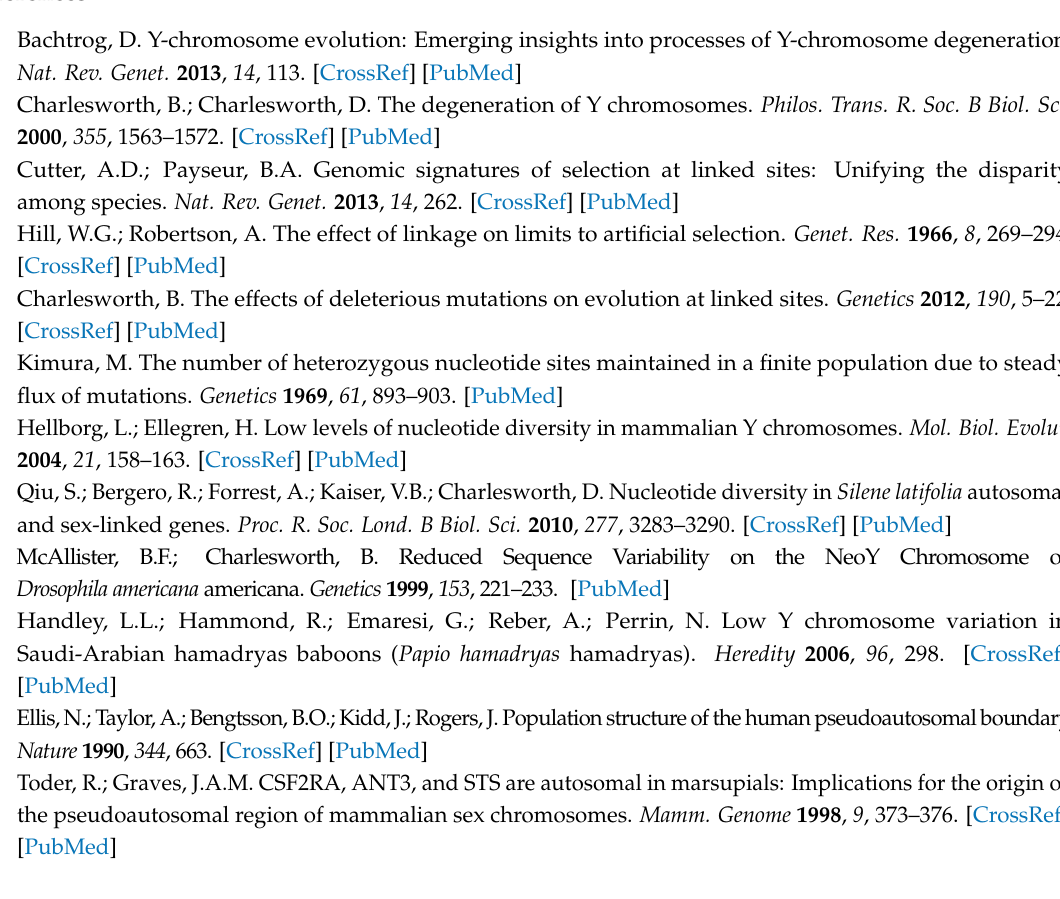
Table S1: Samples used for genetic mapping of the sex locus of E. siliculosus ; Table S2: Natural populations used for ddRAD sequencing and ddRAD-seq data summary; Table S3: Samples used in the analysis of the population genetics statistics in coding regions; Table S4: PCR primers used for amplification of the PAR and SDR genes; Table S5: Summary statistics of the VCF files; Figure S1. Mapping of the sex-determining region in Ectocarpus siliculosus ; Figure S2. Population genetics statistics for the three Ectocarpus siliculosus genomic compartments: autosomes, PAR and SDR; Figure S3. Population genetics statistics for the individual autosomes, PAR and SDR in Ectocarpus siliculosus ; Figure S4. Comparison of neutral diversity patterns along the sex chromosome of Ectocarpus siliculosus between the four study populations; Figure S5. The landscape of neutral diversity ( π ) and recombination rates along the sex chromosome and autosomes in Ectocarpus siliculosus ; Figure S6. Correlation between neutral diversity and recombination